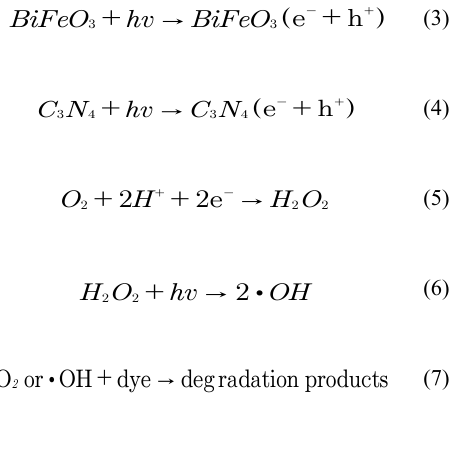
Figure 9. A proposed photocatalytic mechanism of g-C composite for the degradation of MB under simulated sunlight